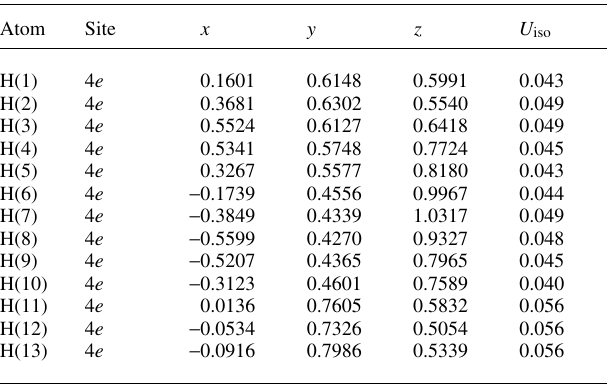
Table 2. Atomic coordinates and displacement parameters (in Å 2 ) .